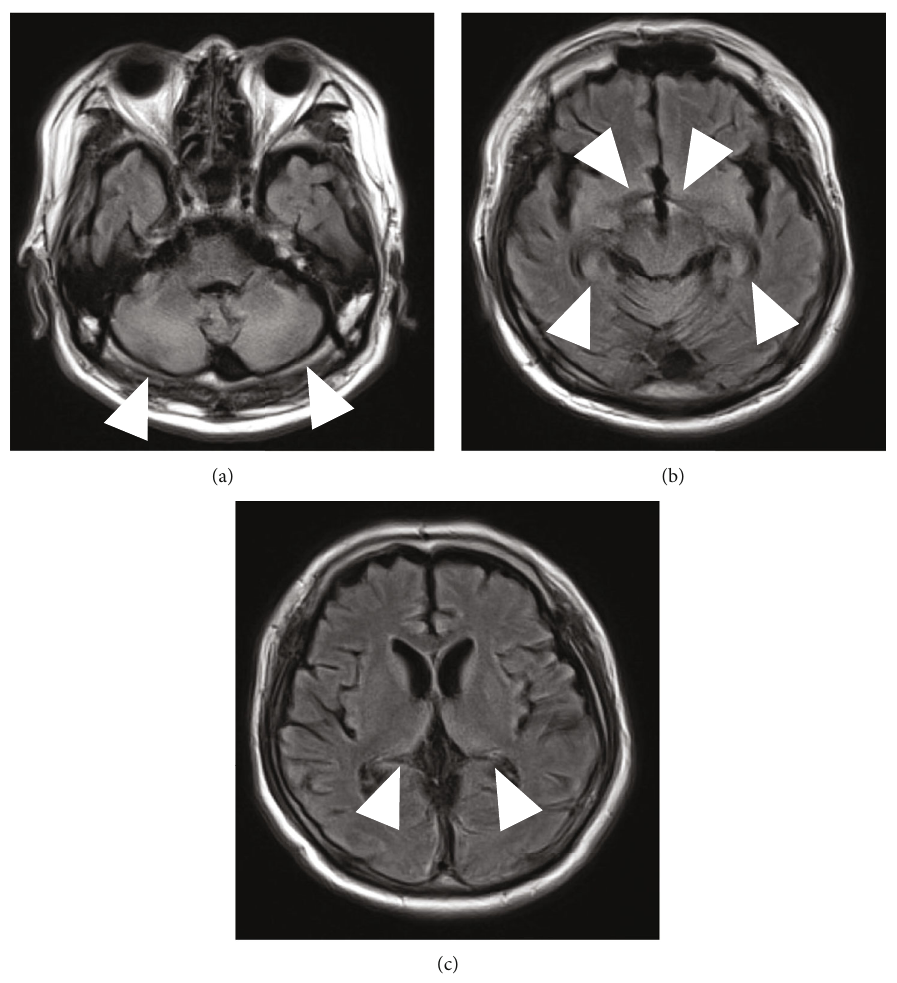
Figure 5: MRI on day 57 revealed symmetrical hyperintensity in the bilateral pons, cerebellar hemispheres, hippocampus, thalamus, and hypothalamus on FLAIR. (a) Cerebellar hemispheres (arrow). (b) Hippocampus and hypothalamus (arrow). (c) Thalamus (arrow). FLAIR: fl uid-attenuated inversion recovery; MRI: magnetic resonance